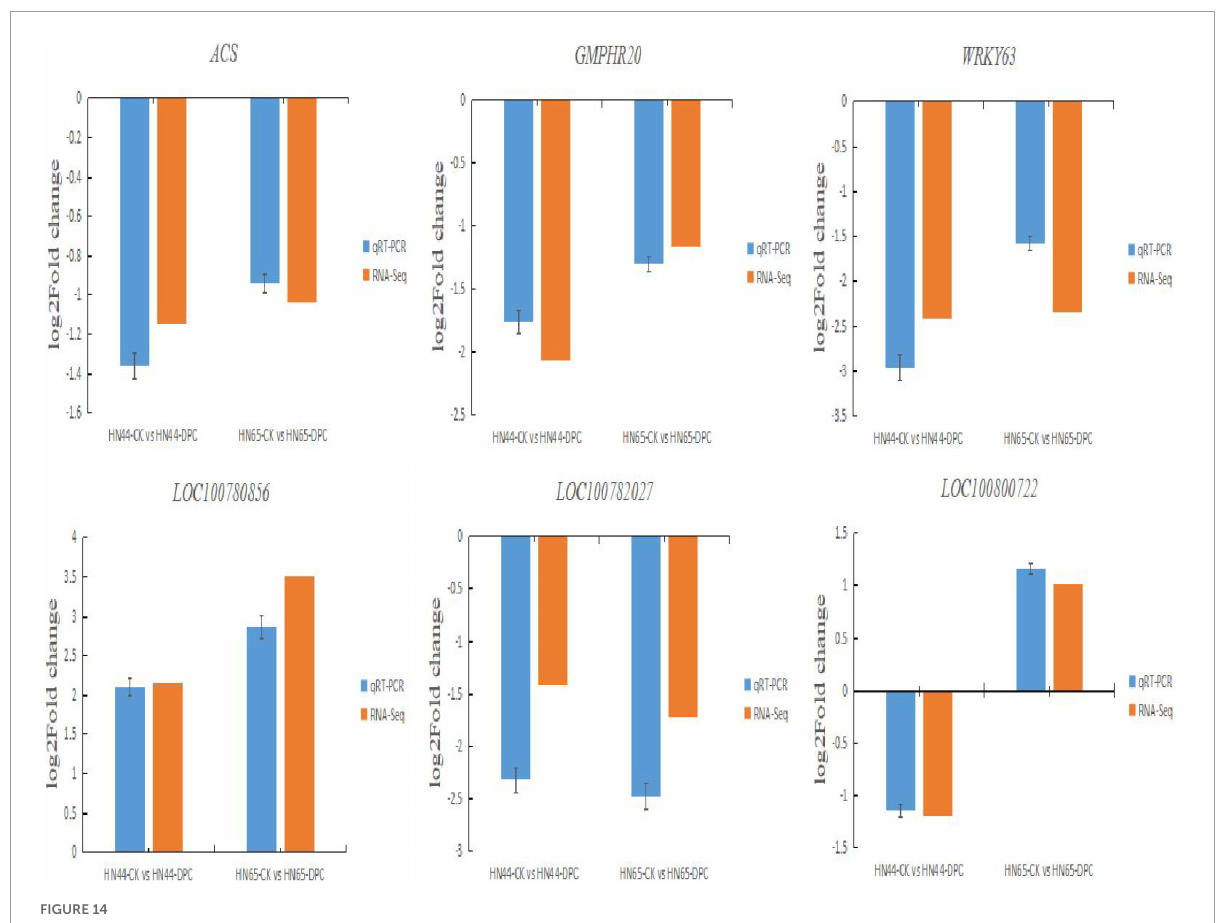
FIGURE14 Verification of RNA-seq results by